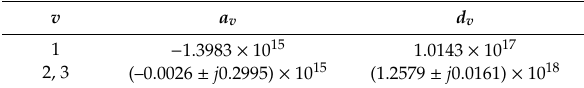
Table 2. a v and dv of trilayer graphene surface resistivity.